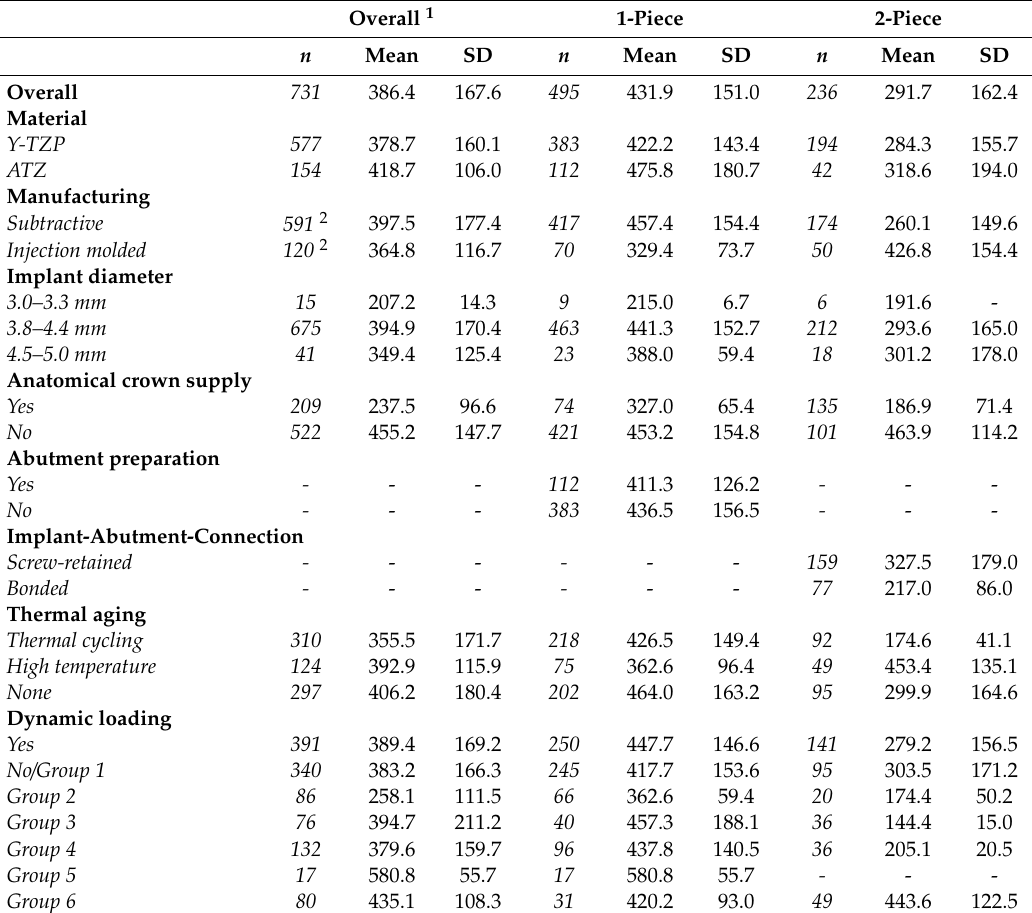
Table 3. Calculated mean bending moment (in Ncm) and standard deviation depending on the implant design, several covariables and